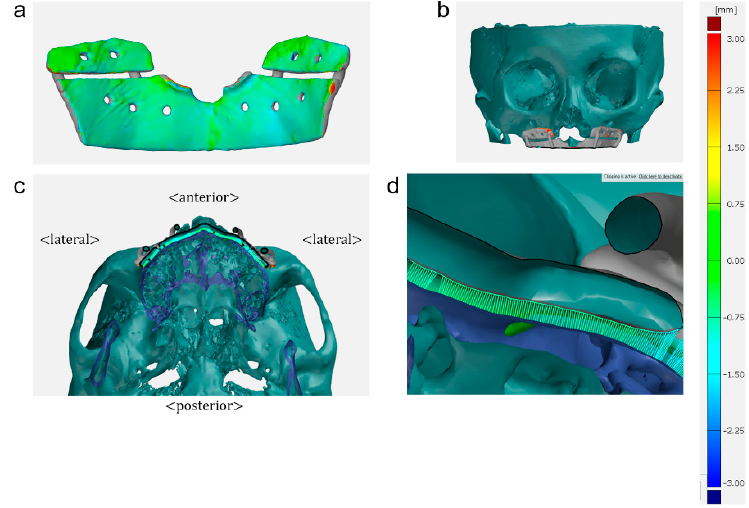
Figure 4. A color difference map for evaluation of fitness of the template. ( a ) A 3D color difference map of fitness of the template for skull #1. ( b – d ) Assessment of fitness using 2D (two-dimensional) cross-sectional cut for skull #1.